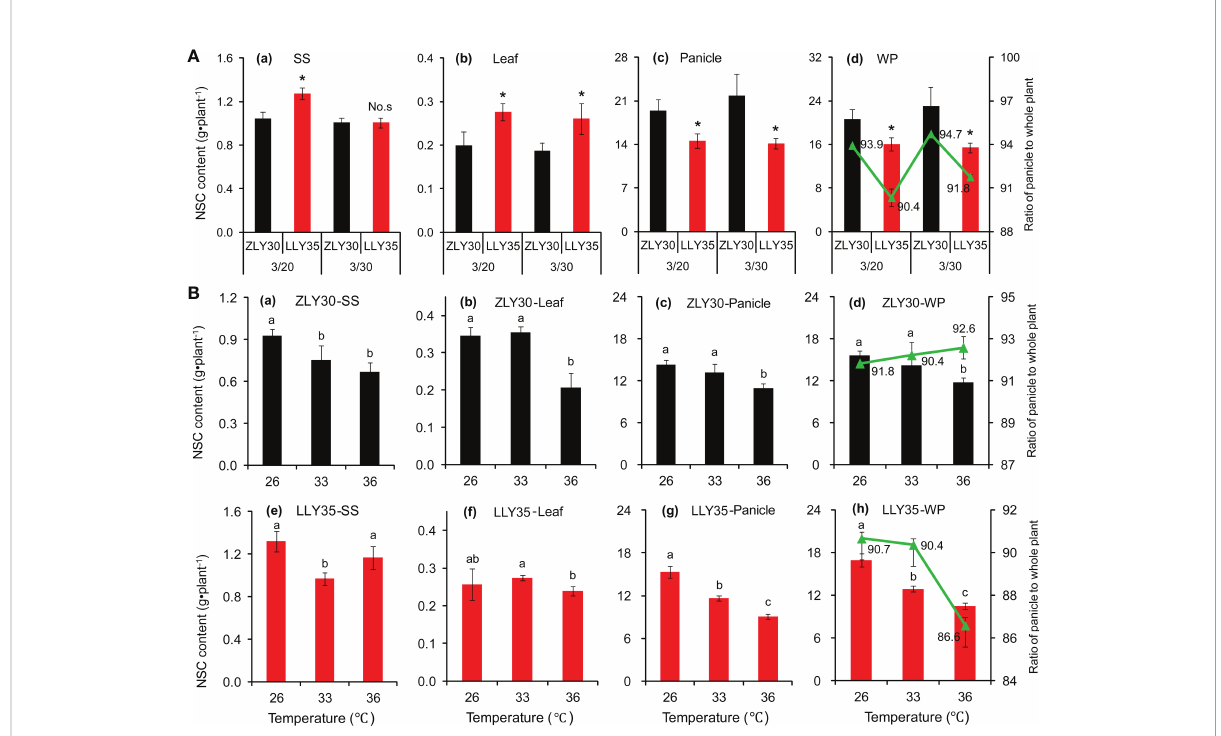
FIGURE 3 Effect of different sowing times and temperatures on non-structural carbohydrate (NSC) accumulation and distribution of rice. (A) NSC accumulation in stem and sheath (SS), leaves (L), panicle (P), whole plant (W) and distribution in ZLY30 and LLY35 at different sowing times; (B) Changes in NSC accumulation and allocation of two cultivars under different temperatures; Vertical bars denote standard deviations ( n =3). “ * ” indicated signi fi cant difference while “ No.s ” indicate no signi fi cant difference at the 0.05 probability level between the ZLY30 and LLY35 within one sowing time using T-test analysis. Different letters indicate signi fi cant differences with a least signi fi cant difference test at P ≤ 0.05 among different temperatures within one genotype using one-way analysis of